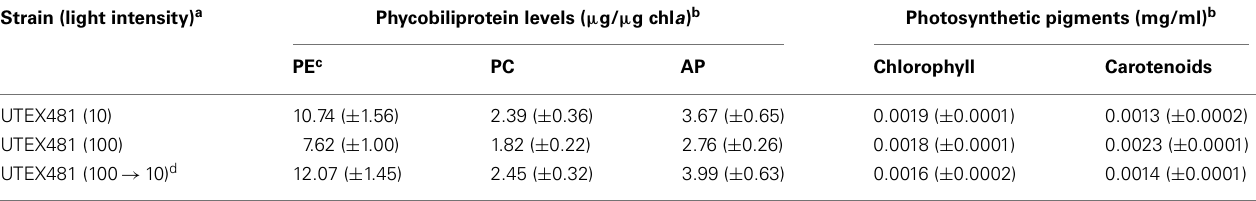
Table 2 | Phycobiliprotein and photosynthetic pigment quantification.